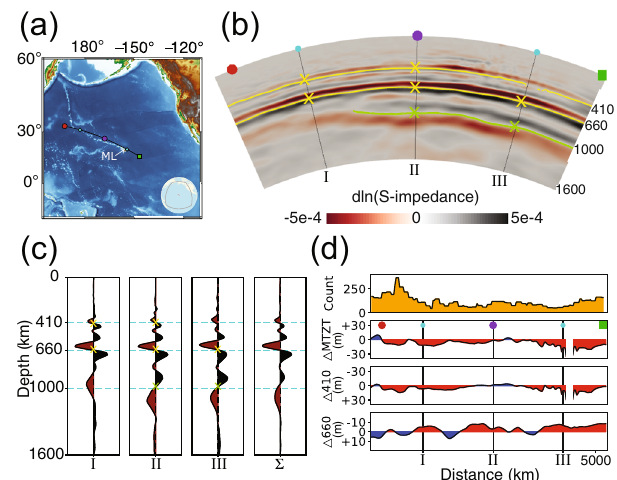
Fig. 3 | Our reverse time migration image of mantle transition zone and mid- mantle discontinuities along the Hawaiian seamount chain. a Geographical situation. b A vertical slice through the imaged impedance contrasts. The traced 410, 660, and 100km discontinuities are drawn in yellow. Three vertical pro fi les through this section are plotted in c . Their stacked pro fi le is in the last panel. d Topographyofthemantletransitionzonediscontinuities.The fi rstrowshowsthe midpoint counts extracted from Fig. 1b along the Hawaiian seamount chain.